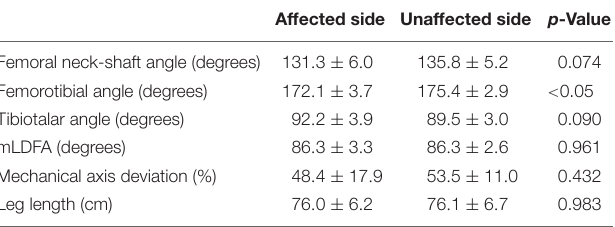
TABLE 3 | Differences in the mean radiographic examination in the affected and unaffected limbs of patients with DDH at the final assessment (mean ± SD). Affected side Unaffected side p -Value Femoral neck-shaft angle (degrees) 131 . 3 ± 6 .